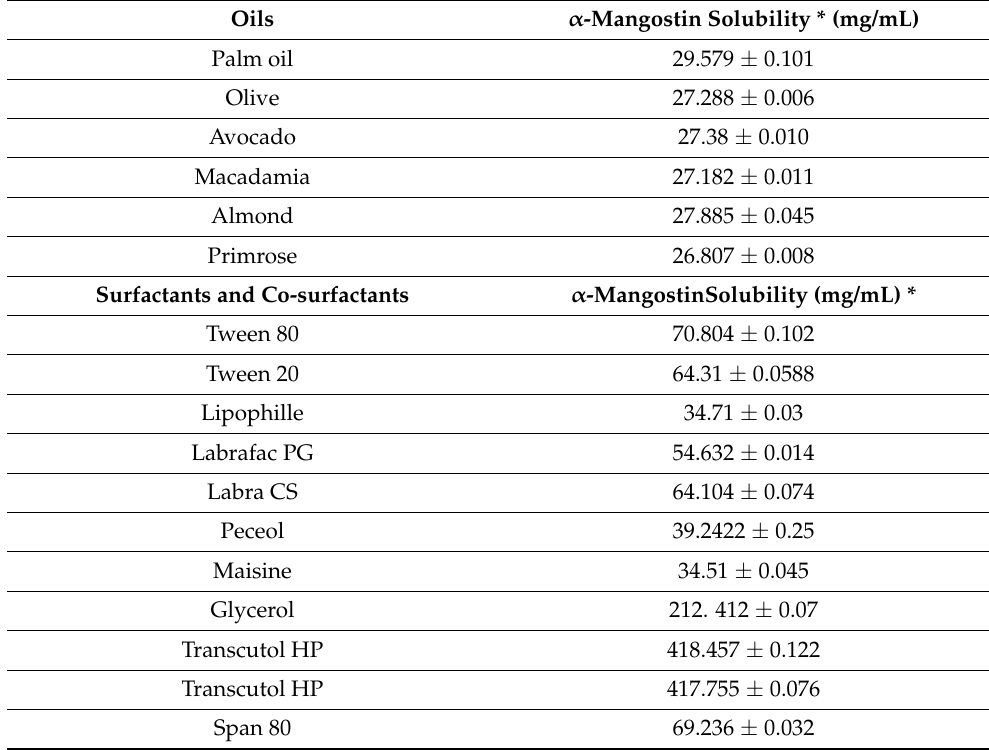
Table 3. Solubility profiles of α -Mangostin in different oils surfactants and co-surfactants.